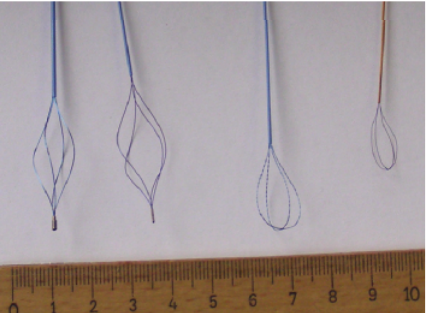
Figure 1: All four different basket types from left to right are as follows: (i) Dormia (Mentor Porg`es), 4 helical wires (diameter 0.25 mm), 3.5 F, nitinol, (ii) Dormia (Mentor Porg`es), 4 helical wires (diameter 0.18mm), 2.5 F, nitinol, (iii) Epflex, tipless, plaited basket (wire diameter 0.127 mm), 2.5 F, nitinol, and (iv) Equadus (OptiMed), tipless basket, 4 wires (diameter 0.07 mm), 1.8 F, nitinol.